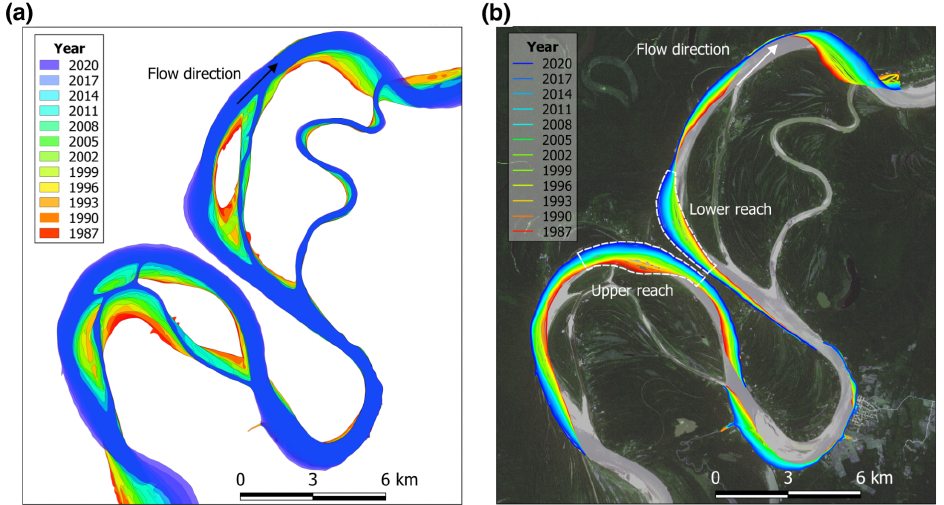
Figure 3. ( a ) Temporal (from 1987 to 2020) migration of the Jenaro Herrera (JH) bend (see Figure 1 for location). ( b ) Outer bank migration from 1987 to 2020.